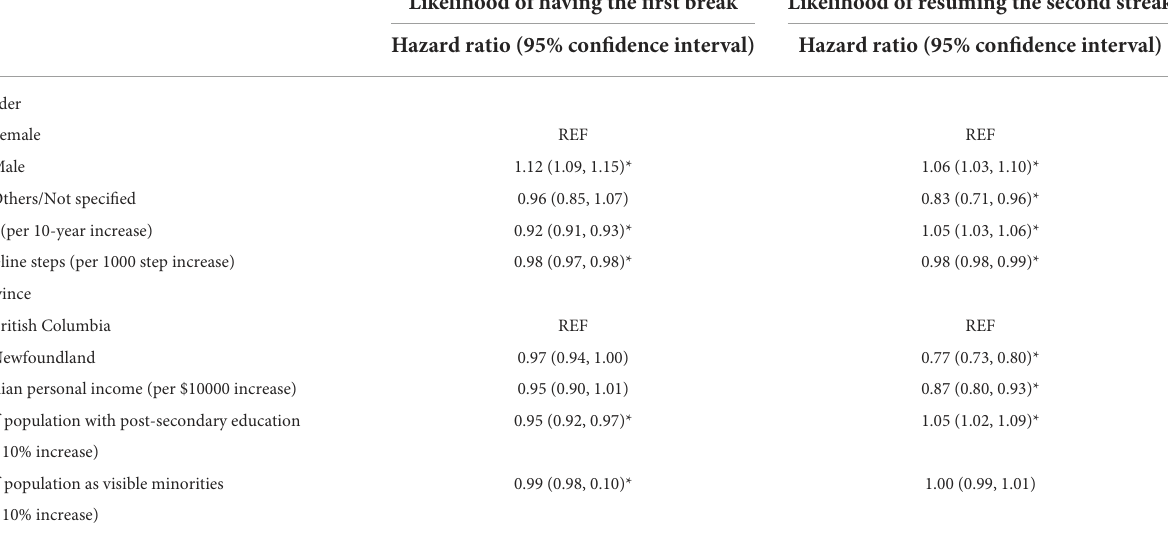
TABLE 3 Hazard ratios for sociodemographic correlates associated with the likelihoods of having time to the first break and resuming the second